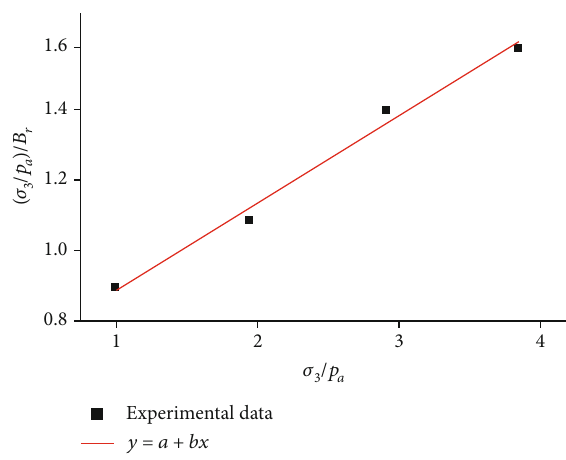
/ p Þ / B ~ σ / p 3 r 3 a a